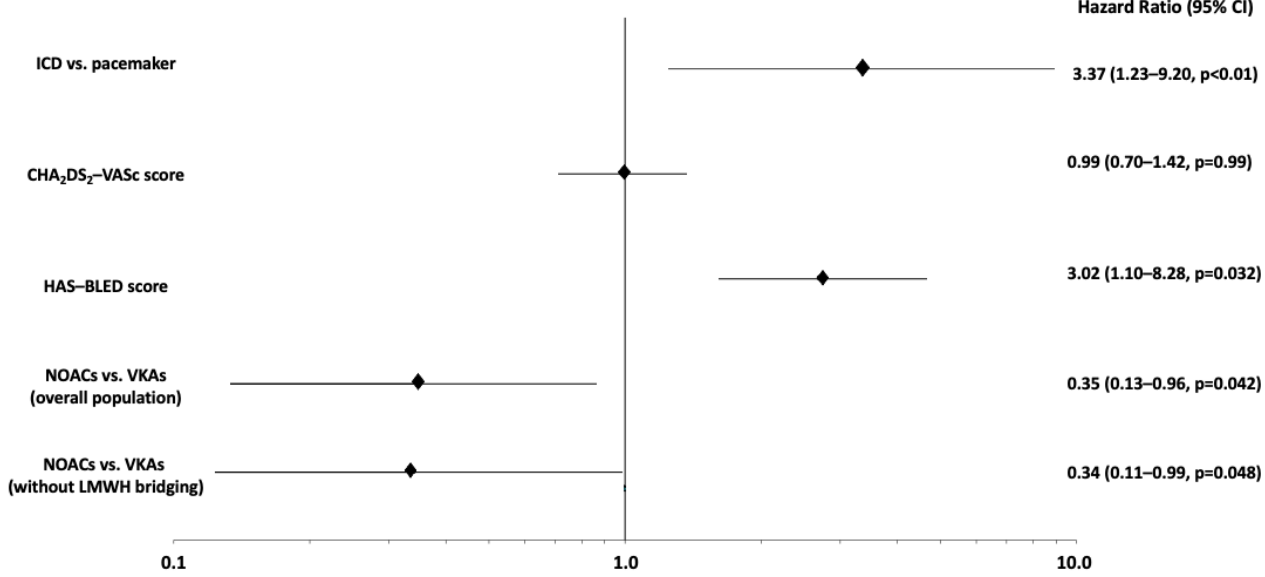
Figure 2. Hazard ratios for post-intervention pocket hematoma (primary endpoint) according to different oral anticoagulation strategies (overall population adjusted for IPW Propensity Score matching and patients without LMWH bridging), various device types, and CHA 2 DS 2 -VASc and HAS-BLED scores. ICD = Implantable cardiac defibrillator; IPW = Inverse-probability-weighting; LMWH = Low molecular weight heparin; NOACs = Non-vitamin K antagonist anticoagulants; VKAs = Vitamin K antagonist anticoagulants.